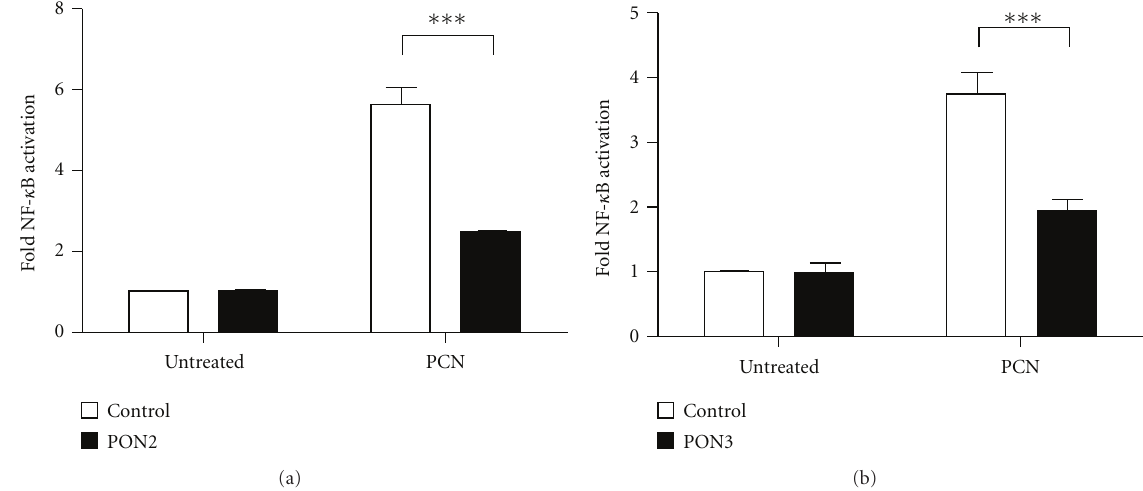
Figure 2: PON2 or PON3 overexpression diminishes NF- κ B activation induced by P. aeruginosa signaling molecule PCN. A549 cells transiently overexpressing HA or PON2-HA (a) and GFP or PON3-GFP (b) were stimulated with PCN (100 μ M, 4h) and analyzed for NF- κ B activation. Symbols represent ± S.E.M. n = 6–9; ∗∗∗ P < 0 .